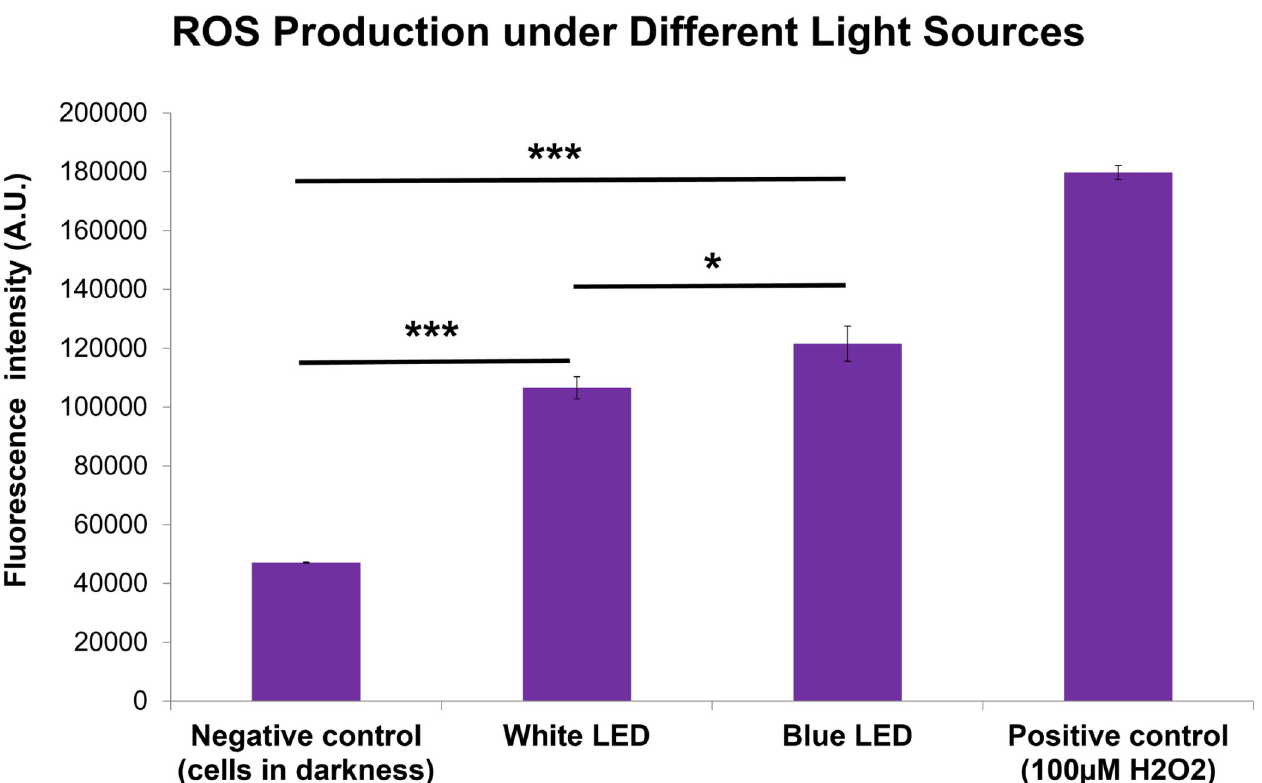
Fig 6. Production of cellular Reactive Oxygen Species (ROS) under different light sources. Blue and white LED lights increased ROS generation compared to controls cultured in darkness (p < 0.001). Blue LED light induced a higher ROS production than white LED light (p = 0.021). Hydrogen peroxide at 100 μ M was used as a positive control. (n = 3, one way ANOVA, � p < 0.05, ��� p < 0.001.) The values are expressed as Mean ±